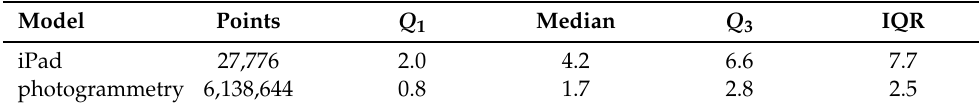
Figure 8. Comparison of measured data with model for room interior. Photogrammetry: ( a ) textured mesh, ( b ) point cloud, ( c ) histogram of distances to the model; iPad: ( d ) mesh, ( e ) point cloud, ( f ) histogram of distances to the model. Point clouds are coloured according to histogram data. Table 5. Comparison of statistical values for the room model [cm].